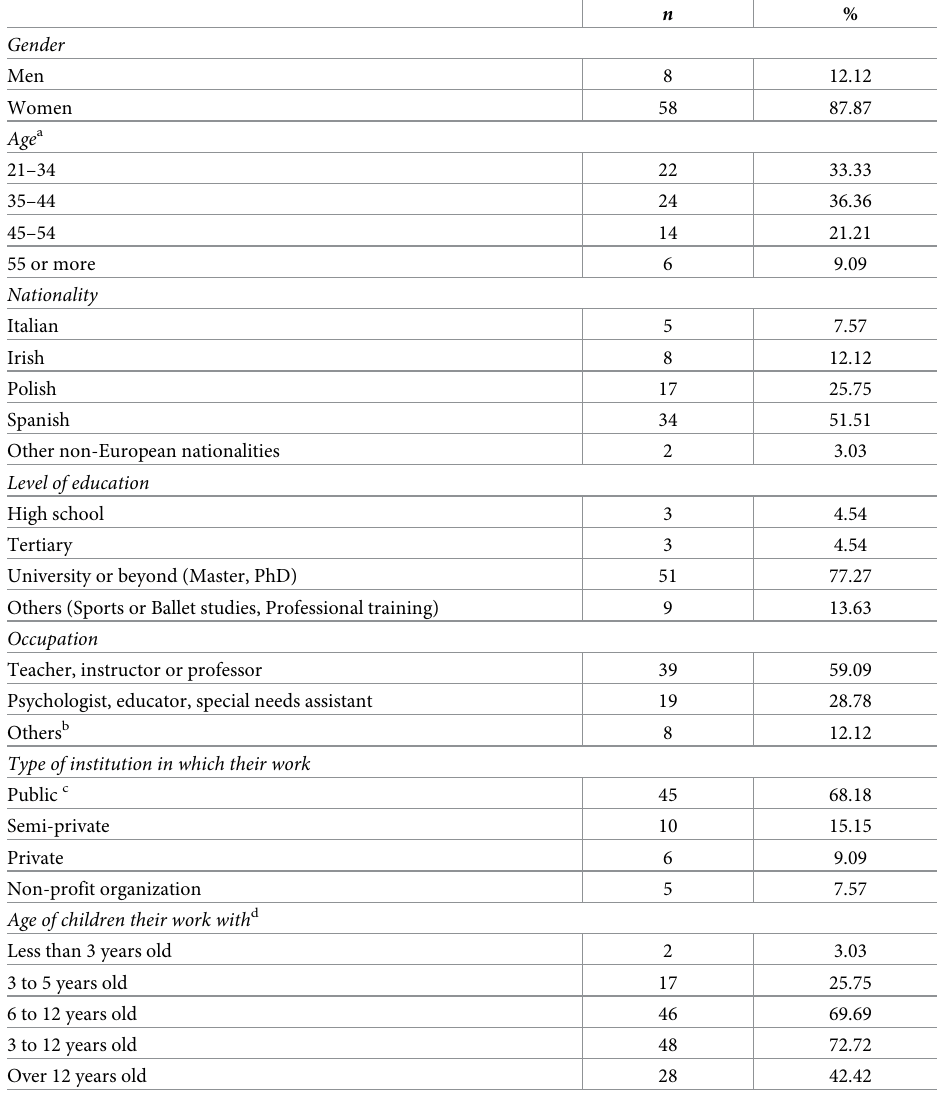
Table 2. School staff participants (Study